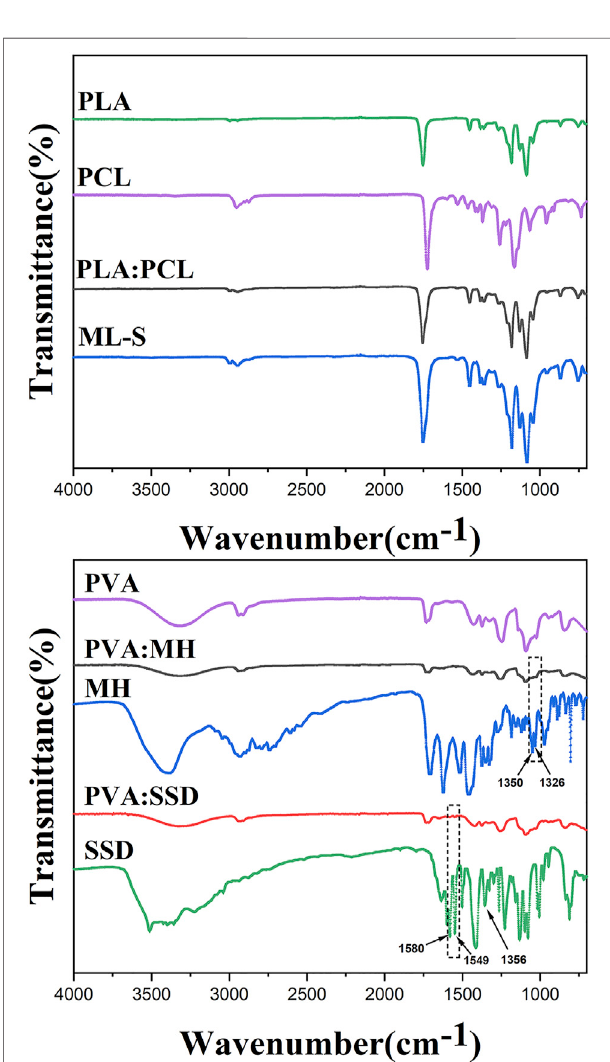
FIGURE4| FTIRspectraofPLA,PCL,PLA:PCL,ML-S,PVA,MH,SSD, PVA: MH, and